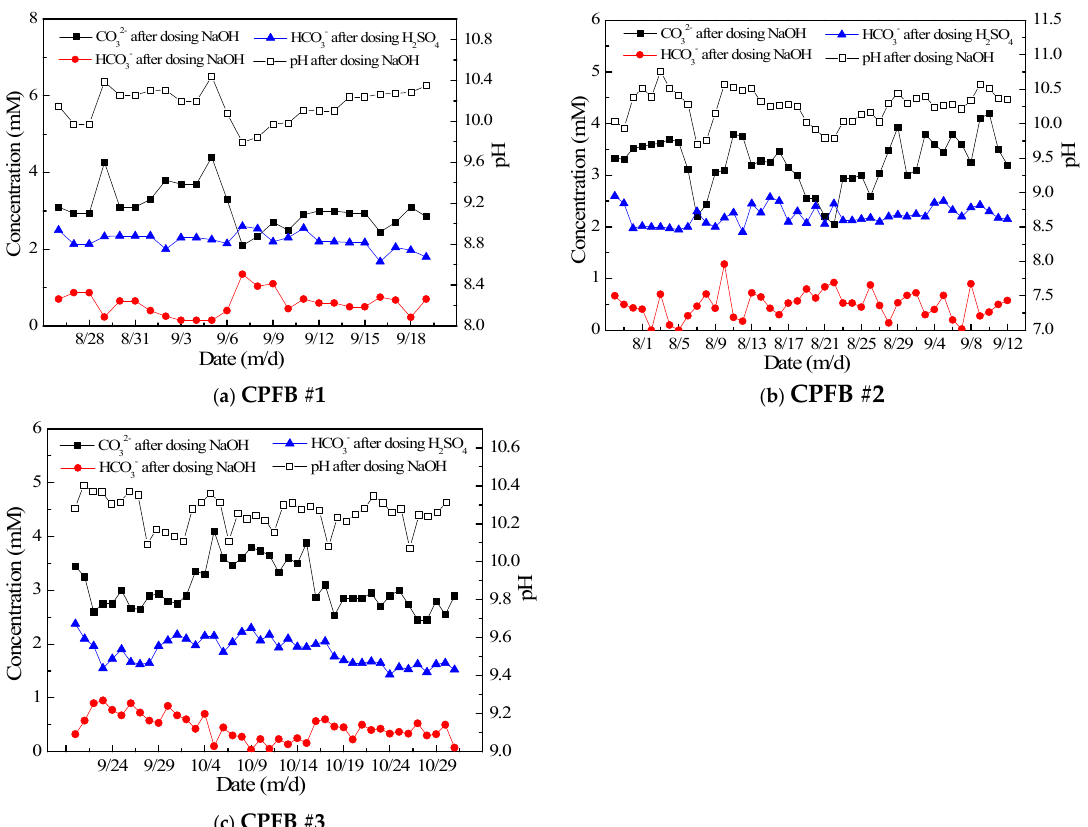
Figure 5. Alkalinity removal performance of the CPFBs. (( a )-alkalinity removal performance of the circulating pellet fluidized bed(CPFB) 1# at di ff erent dates; ( b )-alkalinity removal performance of the circulating pellet fluidized bed(CPFB) 2# at di ff erent dates; ( c )-alkalinity removal performance of the circulating pellet fluidized bed(CPFB) 3# at di ff erent